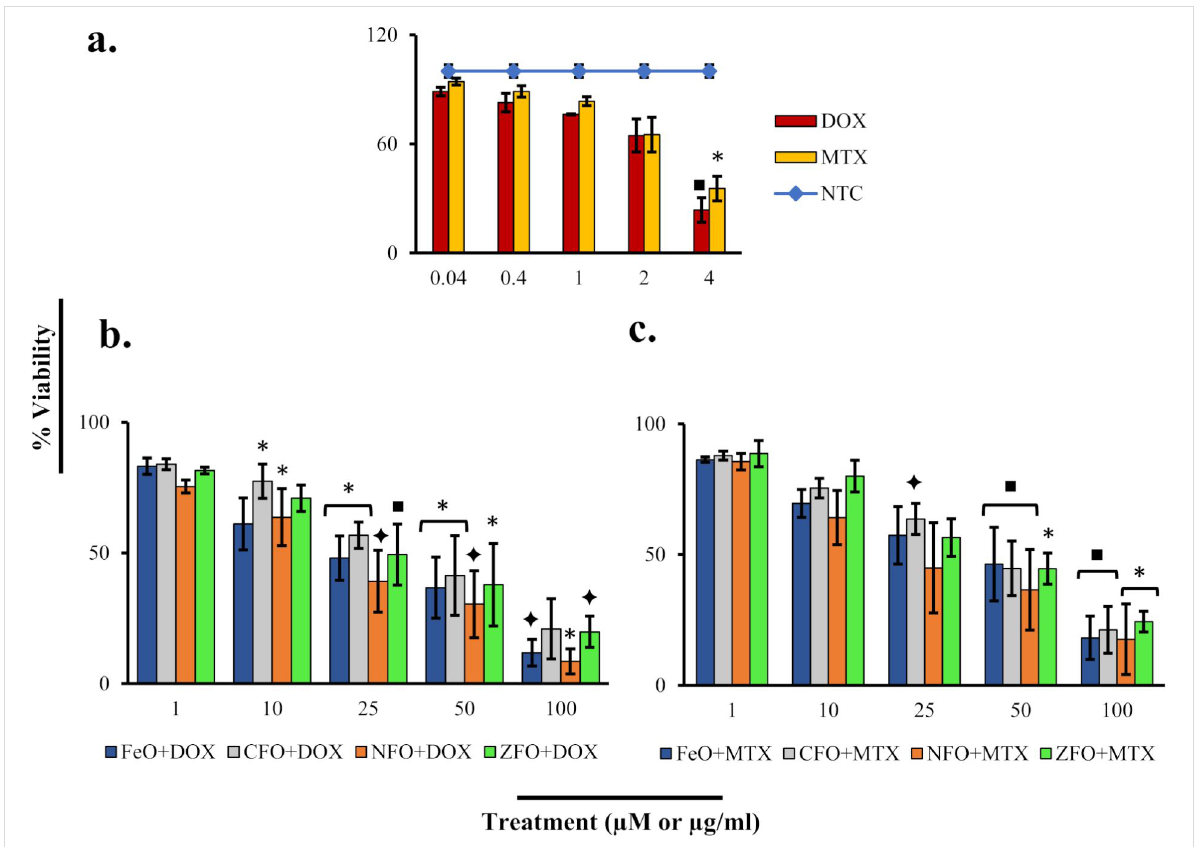
Figure 10: Dose-dependent cytotoxicity of fresh human lymphocytes treated with (a) free DOX and MTX (0.04, 0.4, 1, 2, and 4 µM equivalent to drug attached with NPs at tested doses) and NTC. (b) DOX-, and (c) MTX-loaded MFe 2 O 4 (M = Fe, Co, Ni, Zn) NPs incubated for 24 h (1, 10, 25, 50, and 100 µg/mL). Plotted data indicates mean ± SD of three independent biological replicates with triplicates for all samples. p < 0.05 (one asterisk), p < 0.01 (black square symbol), p < 0.005 (black diamond symbol), paired two-tailed t -test when samples were compared to NTC.